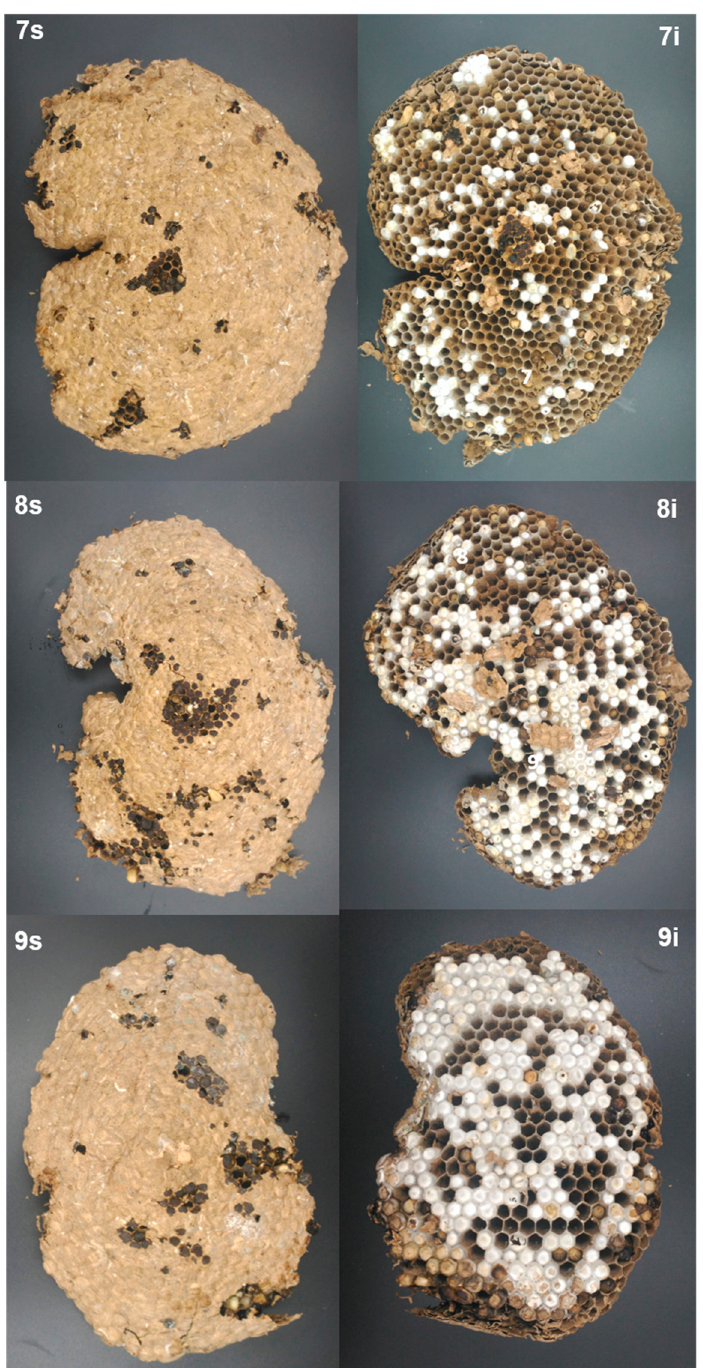
Figure 4. Combs taken from V. velutina nest B. The figures show both superior (s) and inferior (i) views of the combs (n = 9) labeled from top to bottom (1–9) in the same order that they were found within the nest.